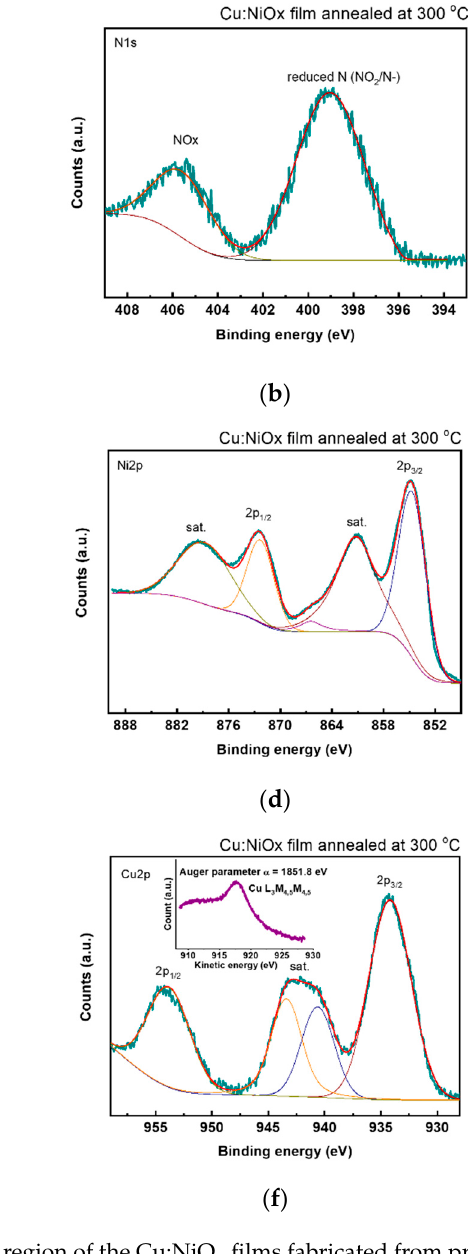
Figure 6. XPS spectra of the ( a , b ) N 1s, ( c , d ) Ni 2p and ( e , f ) Cu 2p region of the Cu:NiO x films fabricated from precursor containing 0.1 Acac and annealed at 200 ◦ C and 300 ◦ C. Inset of panel ( f ): the Cu L 3 M 4,5 M 4,5 Auger XPS